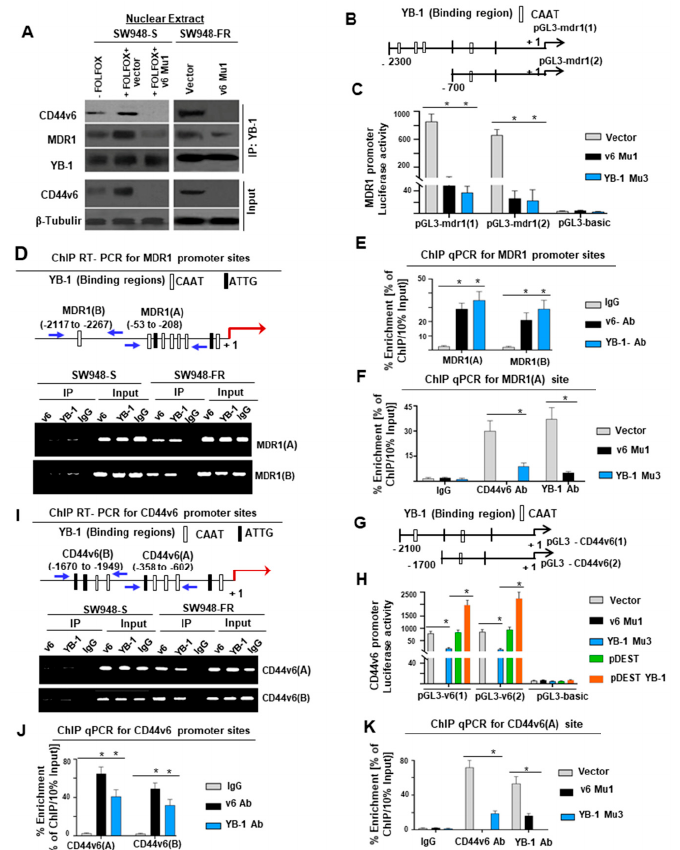
Figure 6. Nuclear YB-1 binds with CD44v6 and modulates CD44v6 and MDR1 transcription by binding to CD44v6 and MDR1 promoters. ( A ) Nuclear extracts were isolated from SW948-S and SW948-FR cells first transfected with vector, or v6 Mu1, and then treated with or without 1 × FOLFOX for 8 h. Nuclear extracts were immunoprecipitated by YB-1 antibody followed by Western blotting of the indicated proteins. ( B ) The scheme shows the MDR1 promoter constructs with YB-1 binding sites (mdr1(1) and mdr1(2)). ( C ) MDR1 Luciferase activities are shown for SW948-FR/CICs overexpressing CD44v6 Mu1, or YB-1 Mu3, or vector (Control) for 24 h. ( D , F ) MDR1 is transcriptionally regulated by YB-1 in SW948-FR/CICs. ( D ) The sketch map shows the predicted YB-1 binding sites (CAAT or ATTG) within the MDR1 promoter (MDR1(A) and MDR1(B)). PCR primers designated for MDR1(A) and MDR1(B) were used for amplification of the potential YB-1 binding sites of the MDR1 gene by ChIP semiquantitative PCR assays using anti-CD44v6, anti-YB-1, or an irrelevant IgG antibody (control). Total genomic DNA was used as input for the ChIP PCR. ( E ) ChIP QPCRs representing the PCR products in CD44v6, YB-1, or IgG immunoprecipitated DNA versus 10% input DNA in SW948-FR/CICs using primers for MDR1(A) and MDR1(B) sites are shown. ( F ) ChIP QPCRs representing the PCR products in CD44v6, YB-1, or IgG in SW948-FR/CICs overexpressing CD44v6 Mu1, or YB-1 Mu3, or vector for 24 h are shown. ( G ) The sketch map of predicted YB-1 binding sites (CD44v6 [1] and CD44v6 [2]) within the CD44v6 promoter is shown. ( H ) CD44v6 luciferase assays are shown for SW948-FR/CICs overexpressing v6 Mu1, or YB-1 Mu3, or vector for 24 h. ( I ) Semiquantitative PCR products using ChIP QPCR primers are shown for designated YB-1 binding sites as CD44v6(A) and CD44v6(B). ( J ) A representative ChIP QPCR representing the PCR product in immunoprecipitated CD44v6 is shown. ( K ) ChIP QPCR using PCR primers for designated CD44v6(A) sites were used for amplification of the YB-1 binding sites of the CD44v6 gene in ChIP assays in untreated CICs, or CICs overexpressing CD44v6 Mu1, or YB-1 Mu3, or vector (Control) for 24 h. Values represent means ± SD; n = 3–5; * p < 0.05, compared to whole cell lysate and nuclear fractions isolated from sensitive cells, sensitive cell groups, vehicle control, IgG control, vector control, and appropriate control groups. Western blot and semiquantitative PCR data are representative of three